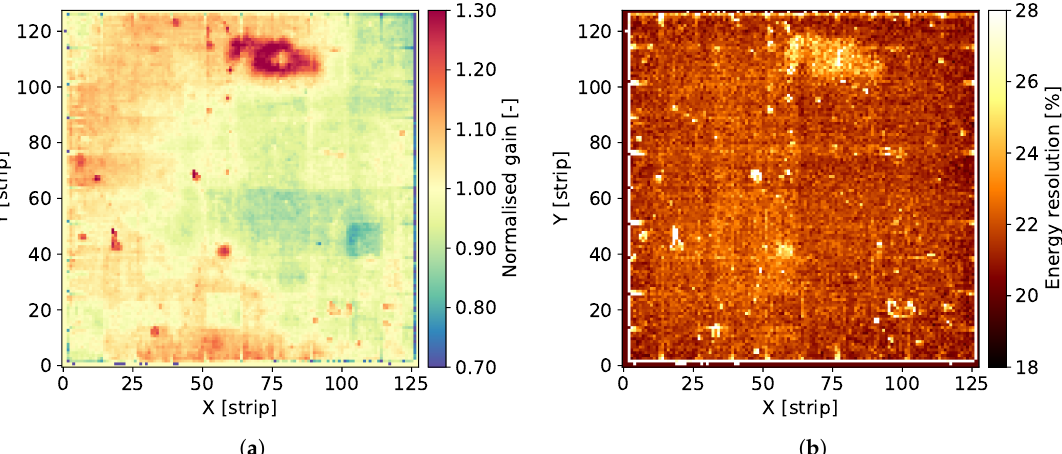
Figure 8. GEM detector B . 2D maps of: ( a ) normalized gas gain; and ( b ) energy resolution for detector bias voltage of